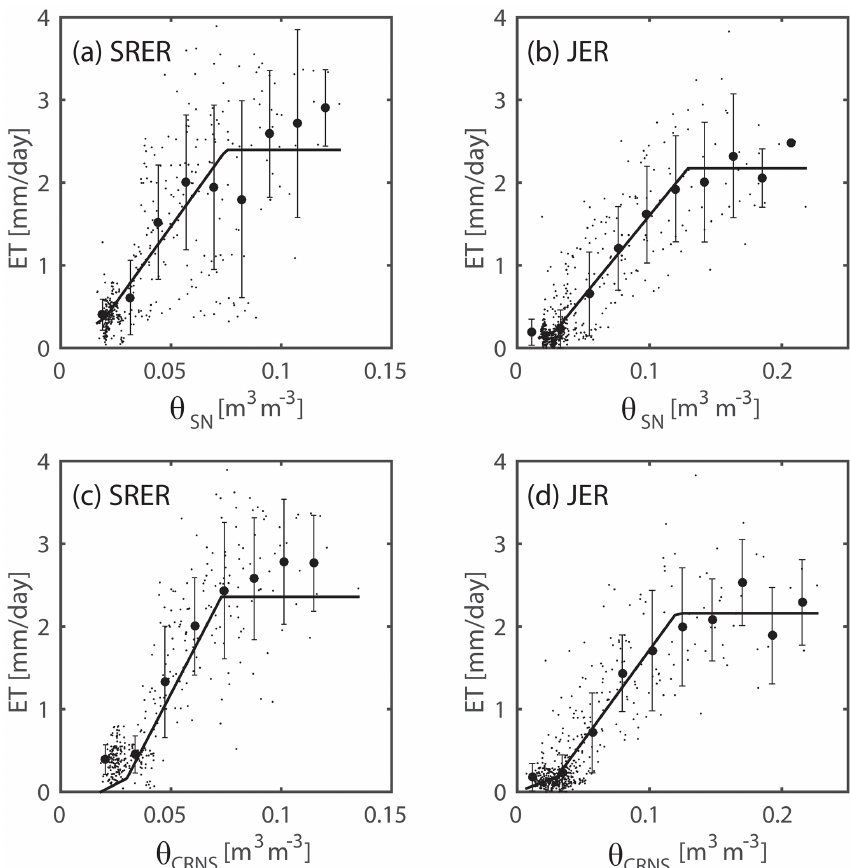
Figure 10. Evapotranspiration relation with the spatially averaged distributed sensor network ( θ SN , top) and the CRNS method ( θ CRNS , bottom) for (a, c) SRER and (b, d) JER. Bin averages and ± 1 standard deviation are shown (circles and error bars) for bin widths of